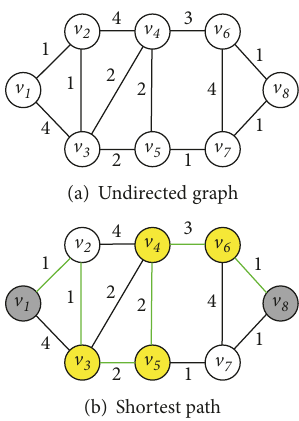
Figure 1: An example of the shortest path with vertex